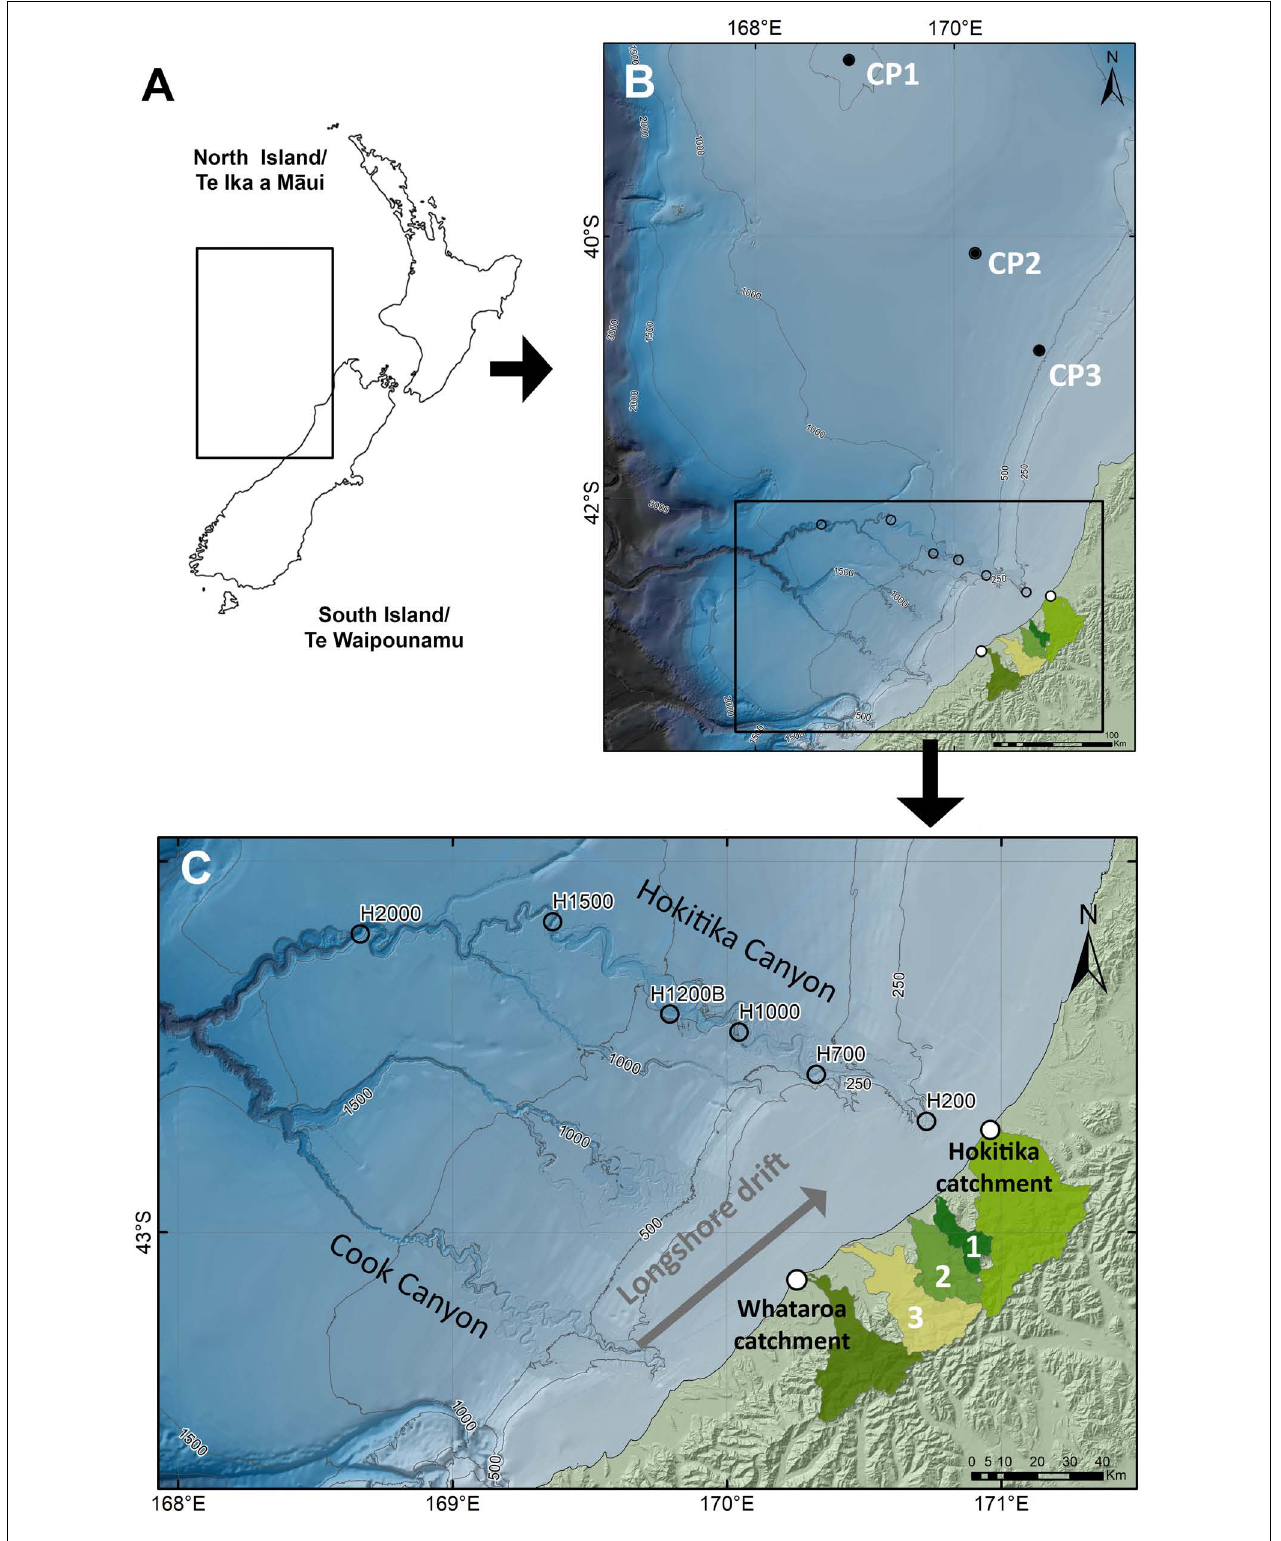
FIGURE 2 | Site and sample location maps of the west coast Hokitika Canyon, showing: (A) the position relative to New Zealand, (B) the position of the Hokitika Canyon sampling sites (open circles) relative to the marine sediment source sites on the Challenger Plateau (CP) and (C) the positions of the main inflow rivers relative to the Hokitika Canyon and the predominant longshore drift direction. Numbered river catchments are: (1) Mikonui, (2) Waitaha, and (3) Wanganui.